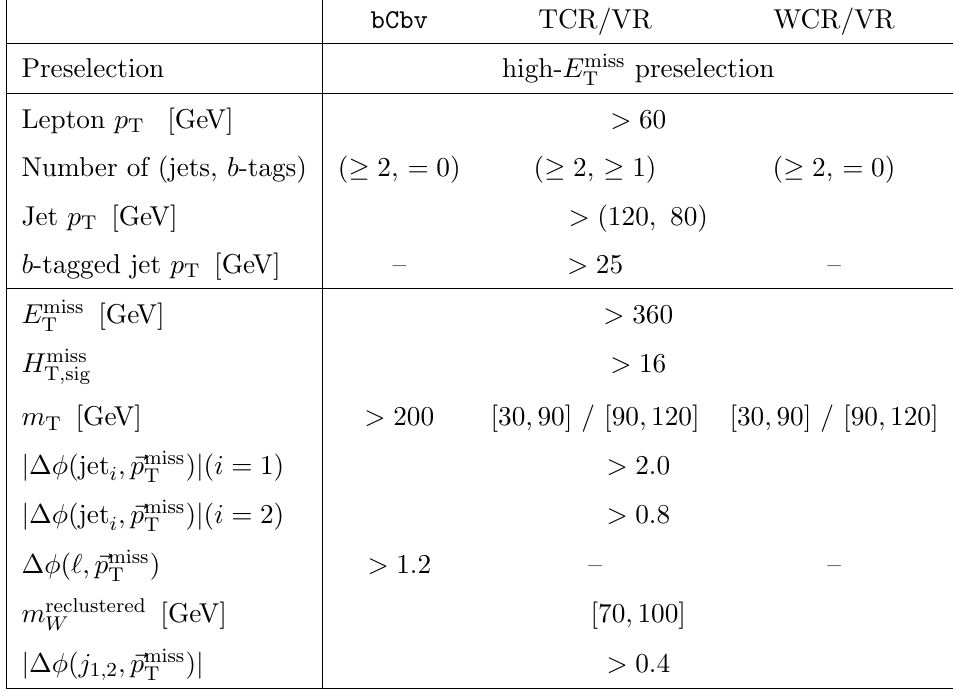
Table 19 . Overview of the selections for the bCbv signal region, as well as the associated control regions for t (cid:22) t (TCR) and W +jets (WCR), and the validation regions targeting t (cid:22) t (TVR) and W +jets (WVR) backgrounds. List values are provided in between parentheses and square brackets denote